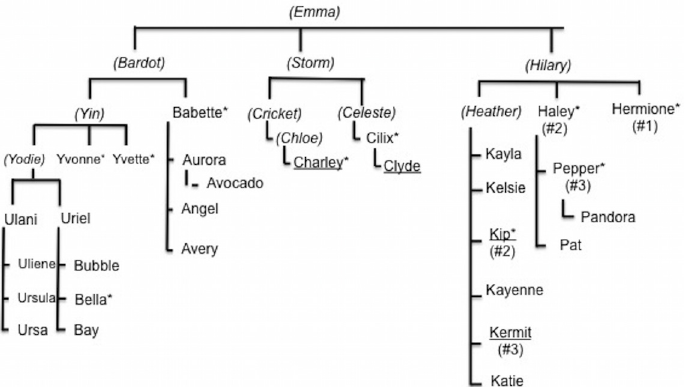
Fig 1. Pedigree of Matriline 3 members from a larger troop of rhesus macaques at the LCE field station. Deceased relatives are denoted by parentheses and italicized font. Underlines indicate males. (#) represents rank within sex (limited to #1–3 to show H1’s relationships to top-ranking members; Alpha male is from matriline 1). * denotes individuals with behavioral